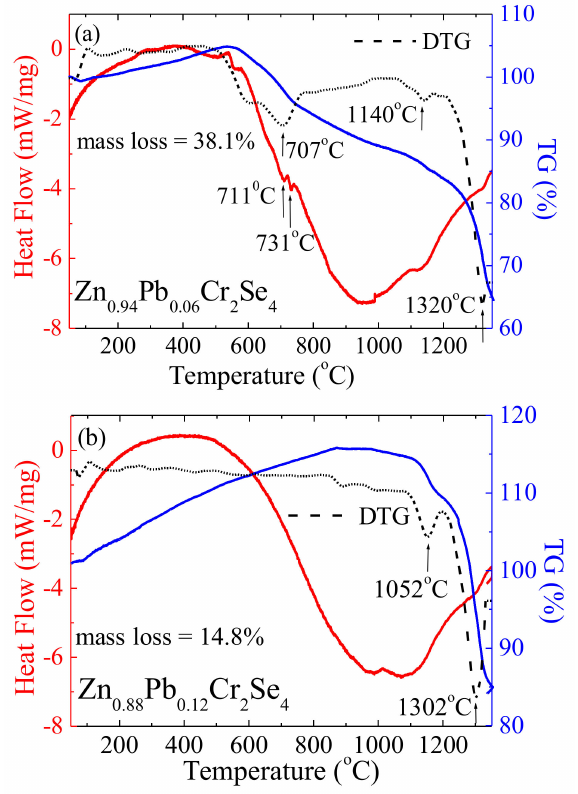
Figure 12. DSC/TG curves for Zn 0.94 Pb 0.06 Cr 2 Se 4 ( a ) and Zn 0.88 Pb 0.12 Cr 2 Se 4 ( b ) single